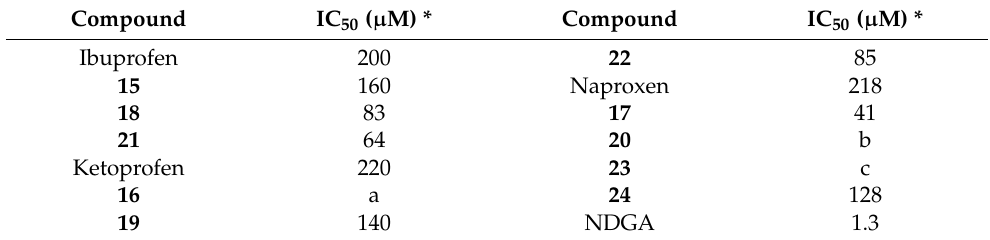
Table 4. Effect of synthesized compounds, ibuprofen, ketoprofen, naproxen, and NDGA on